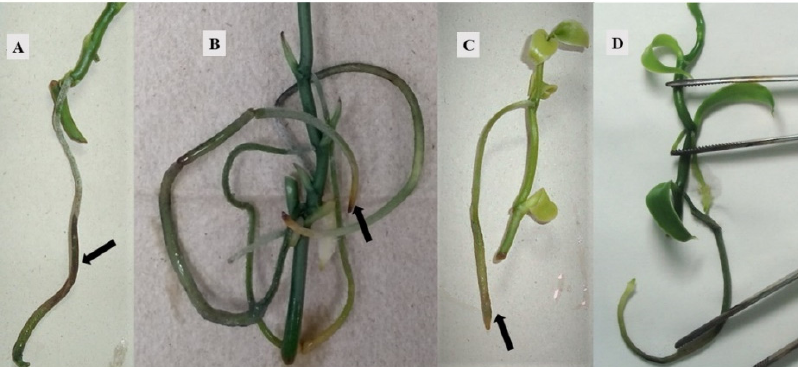
Figure 6. Development of symptoms caused by Fusarium solani in vanilla accessions. ( A ) Root browning in contact with the culture medium, V. planifolia NSF092. ( B ) necrotic tips on roots in contact with the culture medium, V. odorata (NSF023); ( C ) mild root rot in contact with the culture medium of the F 1 hybrid (NSF059 × NSF07). ( D ) control plant not inoculated with the pathogen. Black arrows shown symptoms and signs of the